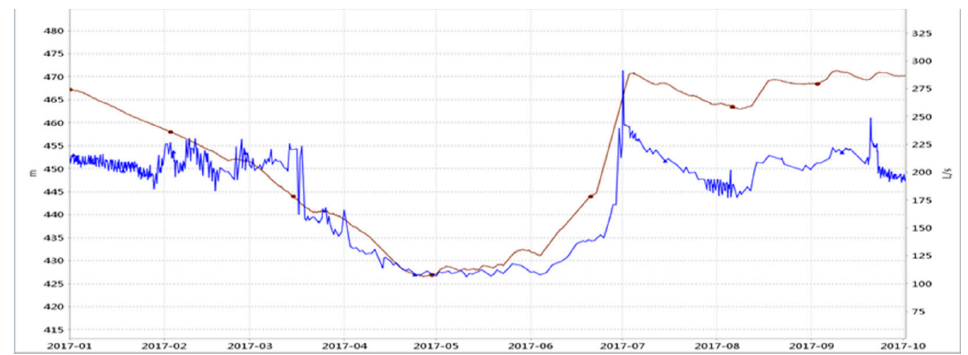
Figure 7. Statistical data for the upstream water level (red line) and the seepage discharge (blue